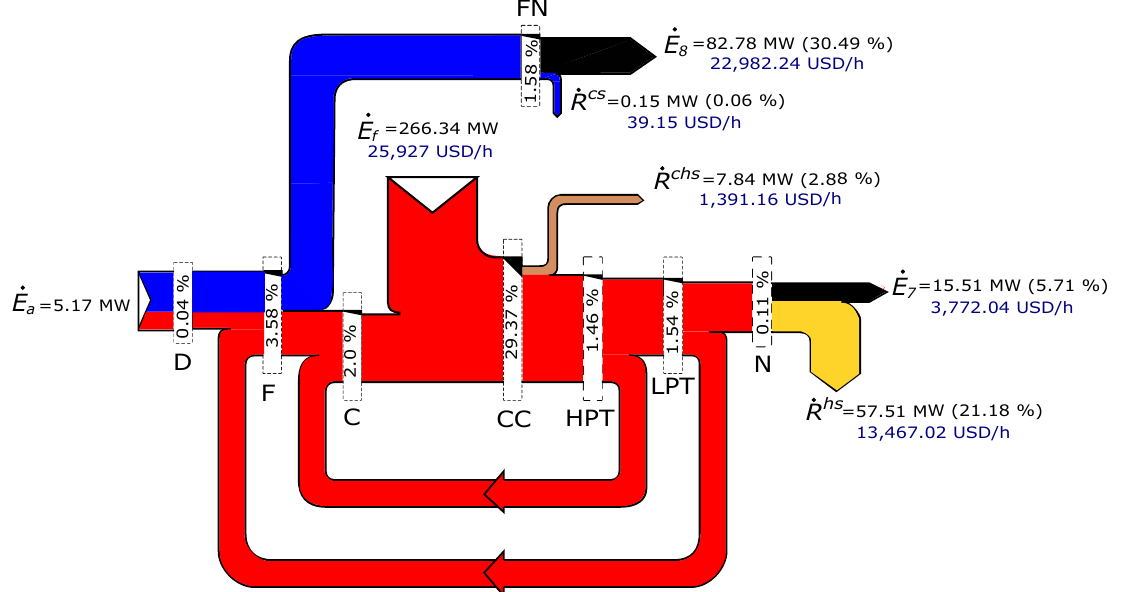
Figure 3. Grassmann diagram of the GE90-11B turbofan engine in the takeoff